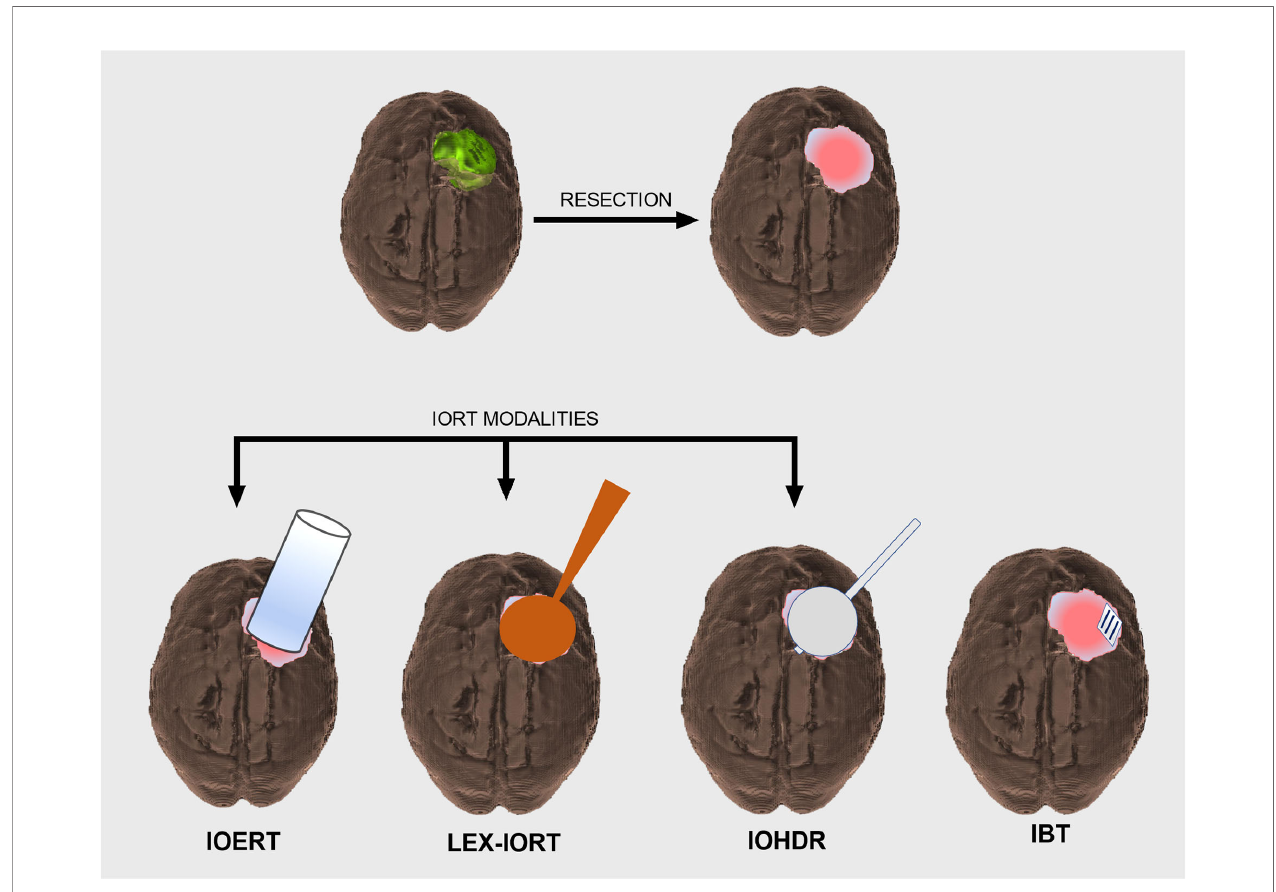
FIGURE 1 | Schematic overview of CNS intraoperative radiotherapy (IORT) modalities. Intracranial tumor ( green ) prior to surgical resection resulting in a postoperative cavity that will require adjuvant radiation treatment ( top row ). IORT options include intraoperative electron radiotherapy (IOERT), low-energy X-ray intraoperative radiotherapy (LEX-IORT), and intraoperative high-dose rate brachytherapy (IOHDR) ( bottom row ). Interstitial brachytherapy (IBT) is distinct from IORT in that radiation dosing extends beyond the anesthetized surgical